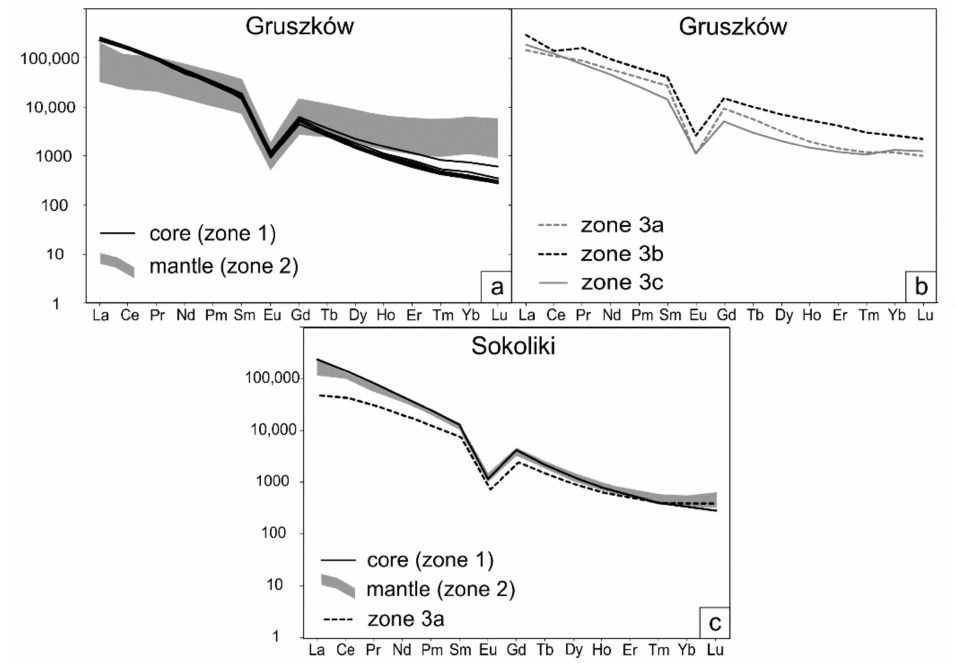
Figure 4. Chondrite-normalized rare earth elements (REE) patterns of all textural groups. Gruszk ó w and Sokoliki allanites are presented separately. Normalizing values are after Sun and McDonough [42]. ( a ) Zones 1 and 2 for Gruszk ó w allanites; ( b ) Zone 3 for Gruszk ó w allanites; ( c ) Zones 1 to 3 for Sokoliki